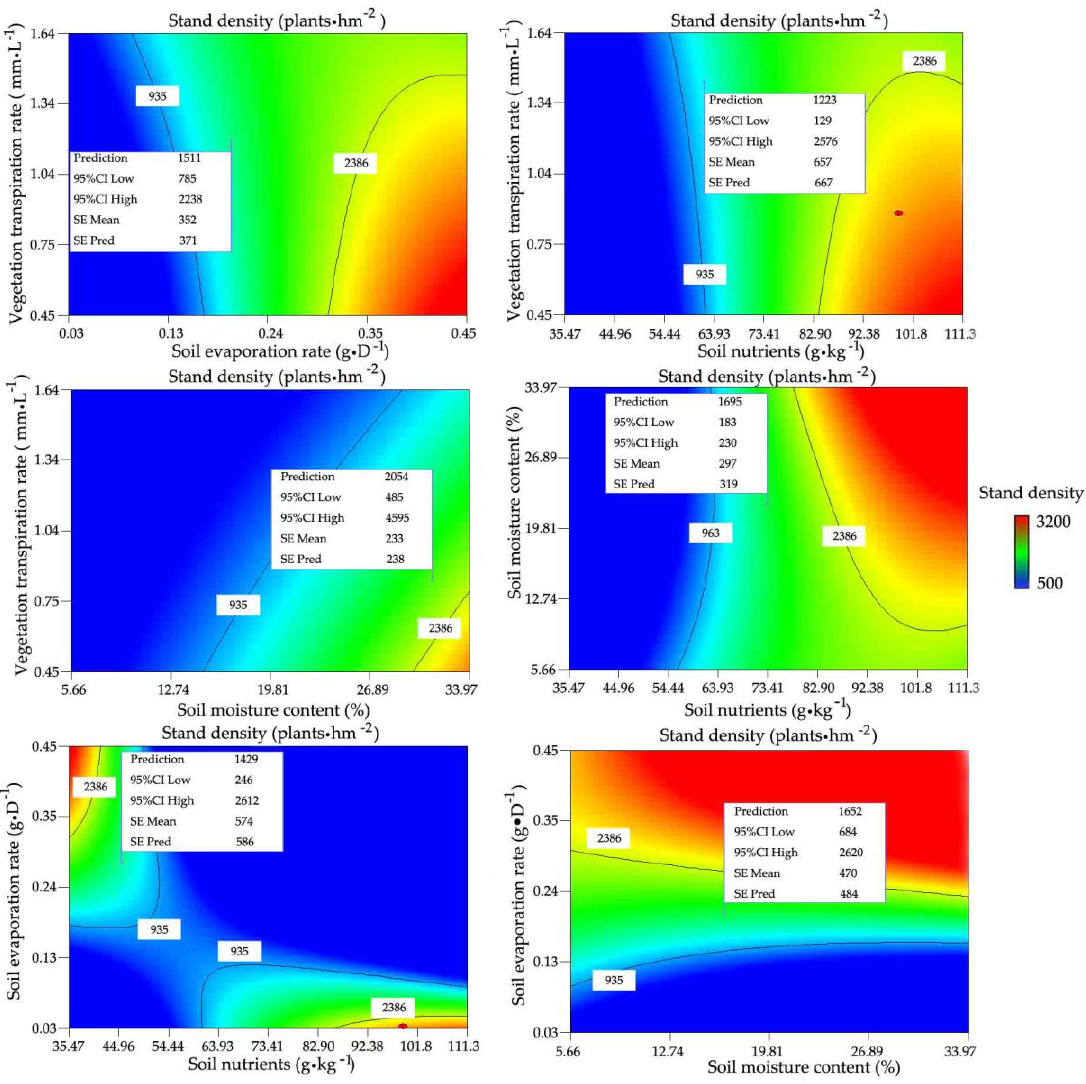
Figure 5. Determining the optimal stand density and its ranges for R. pseudoacacia forest.